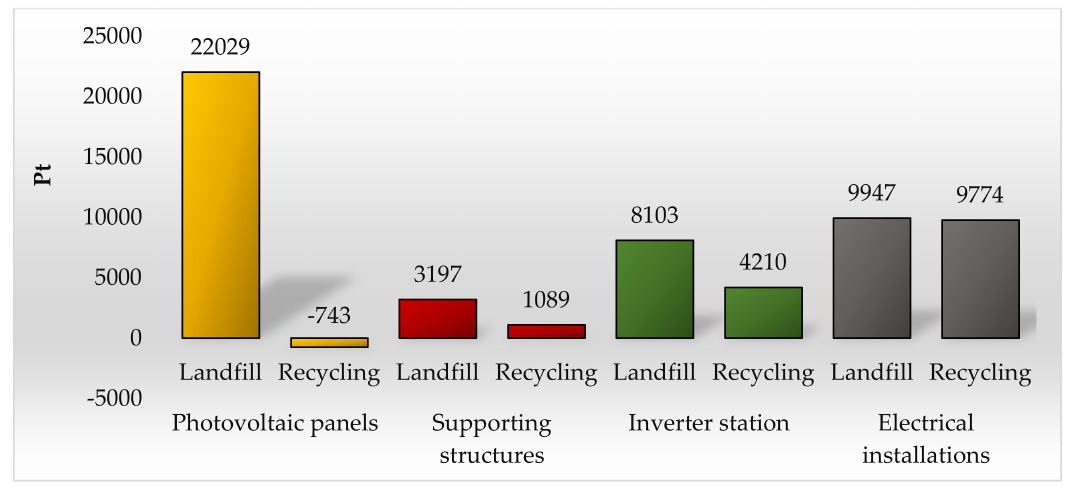
Figure 4. Results of grouping and weighting of environmental impacts occurring during the material life cycle of selected groups of 1 megawatt photovoltaic power plant for all categories of influence [unit: